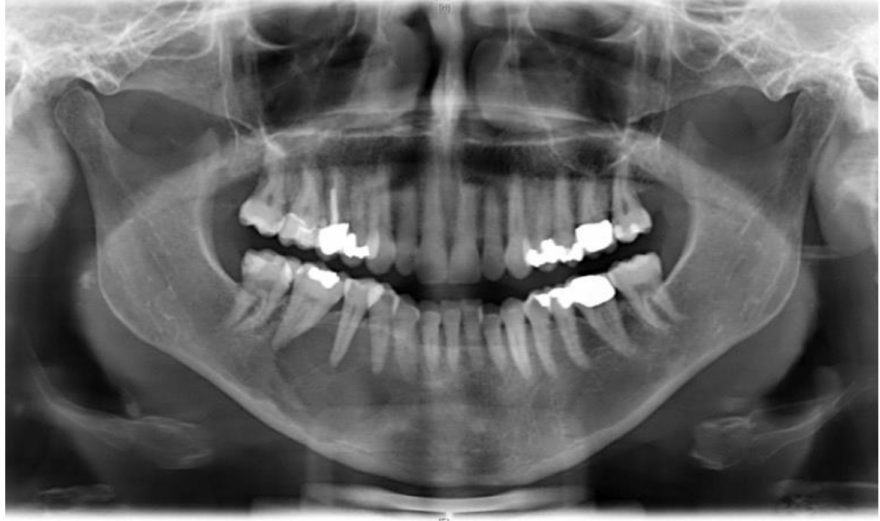
Figure 1. Panoramic X-ray showing an osteolytic lesion on the right side of the mandible. The lesion is associated with root and cortical bone